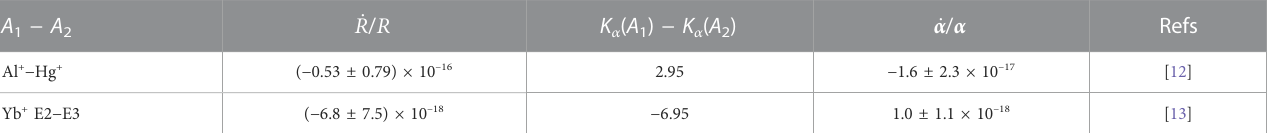
TABLE 2Time-varyingfrequencyratio R measurements using different combinations of optical atomic clocks ( A 1 and A 2 ),andtheircorresponding α varyingsensitivity coef fi cients from two separate works. The inferred limits on the time drift of α are also given from these works.